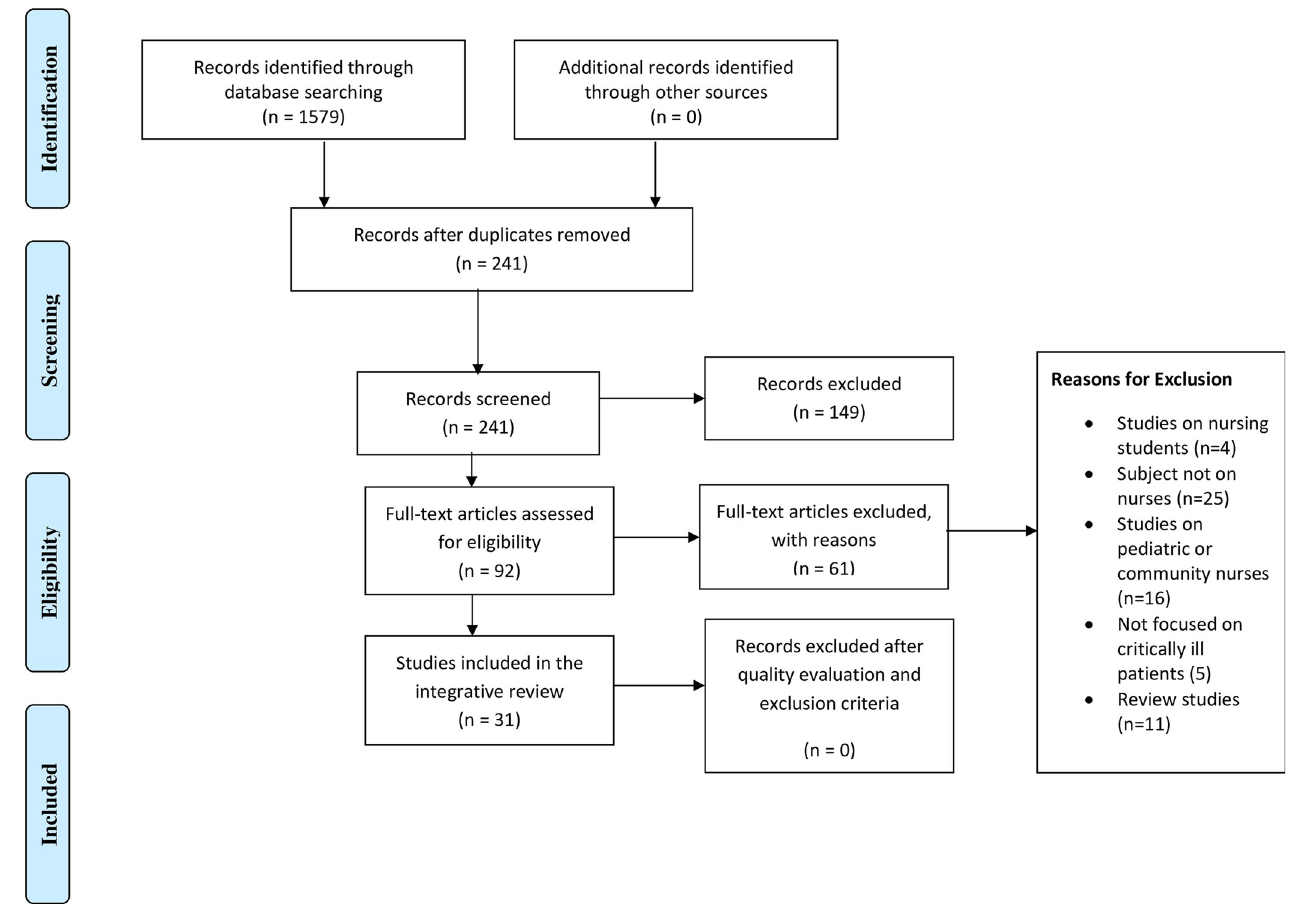
Fig 1. PRISMA flow